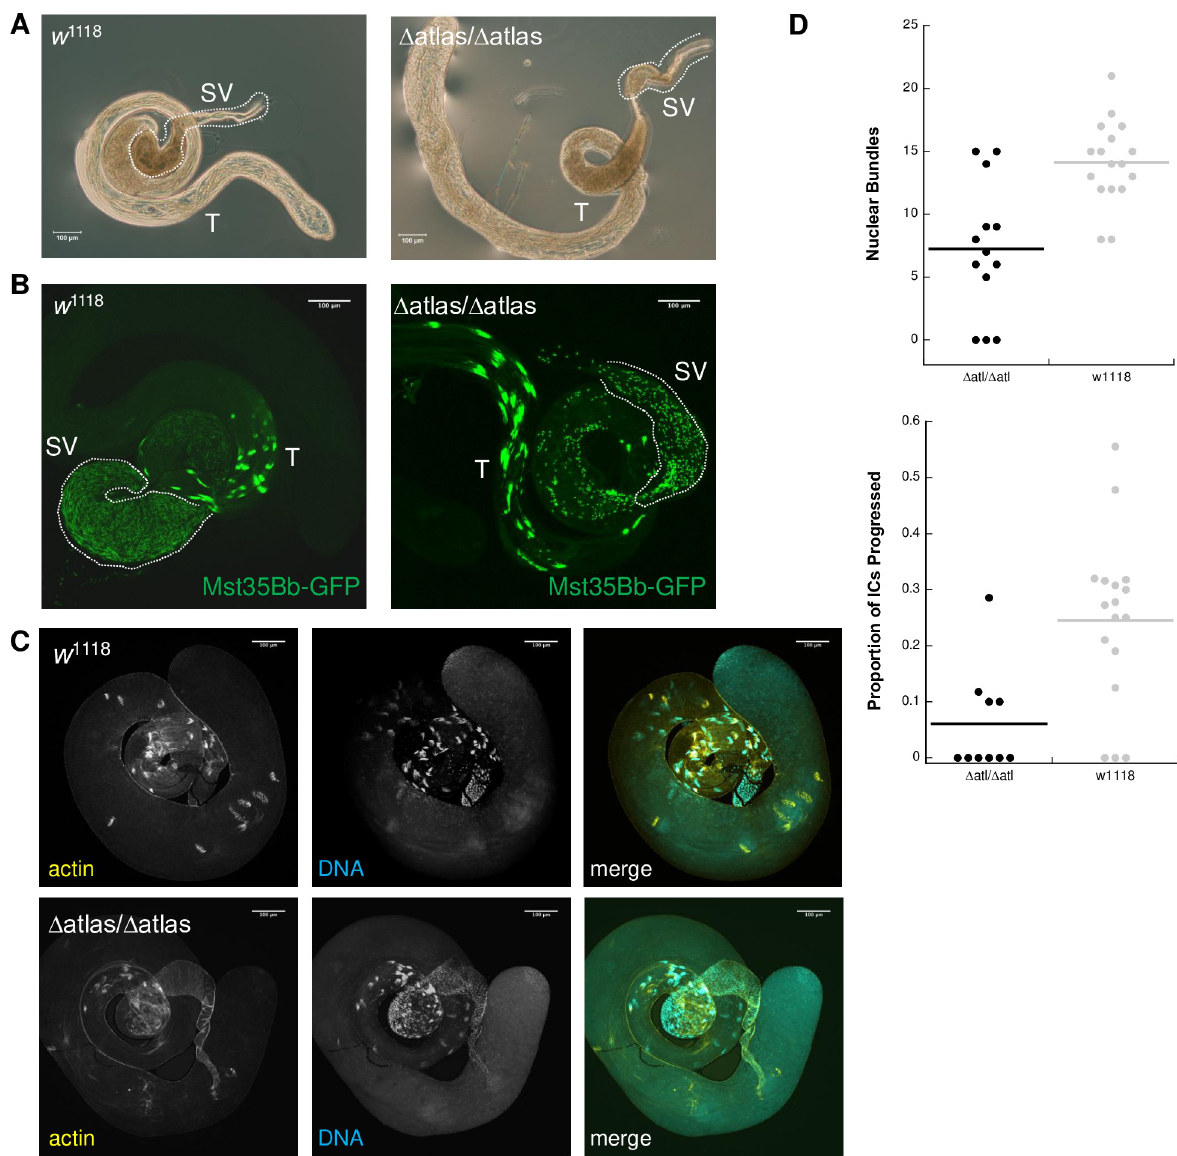
Fig 3. Cytological investigations of the atlas mutant fertility defect. A) Phase contrast microscopy of male reproductive tracts dissected from 7-day-old, unmated control ( w 1118 ) or atlas null males. Control males show the expected accumulation of sperm tails in the seminal vesicle (SV), which appear here as a darker brown shading, while null male have an aberrant accumulation of sperm tails at the basal end of the testis (T). B) Visualization of Mst35Bb-GFP in 4-day old control and atlas null testes. While Mst35Bb localizes to spermatid nuclei in the absence of atlas , the nuclei appear shorter and much less numerous in the outlined SV. C) Representative images from phalloidin staining of w 1118 and atlas null testes used to assess the association of individualization complexes (ICs) with nuclear bundles and the progression of ICs down the length of sperm tails. D) At top, number of nuclear bundles with ICs associated in control and atlas null testes. Significantly more ICs were observed in control testes (control: N = 17, median = 14; mutant: N = 13, median = 7; Wilcoxon rank-sum test W = 34, p = 0.0014). At bottom, proportion of all observed ICs that were intact and that had progressed away from nuclear bundles. Three mutant testes with no observed ICs were excluded from the analysis. A significantly higher proportion of ICs progressed in control testes (control: N = 17, median = 0.27; control: N = 10, median = 0; Wilcoxon rank-sum test W = 28, p =